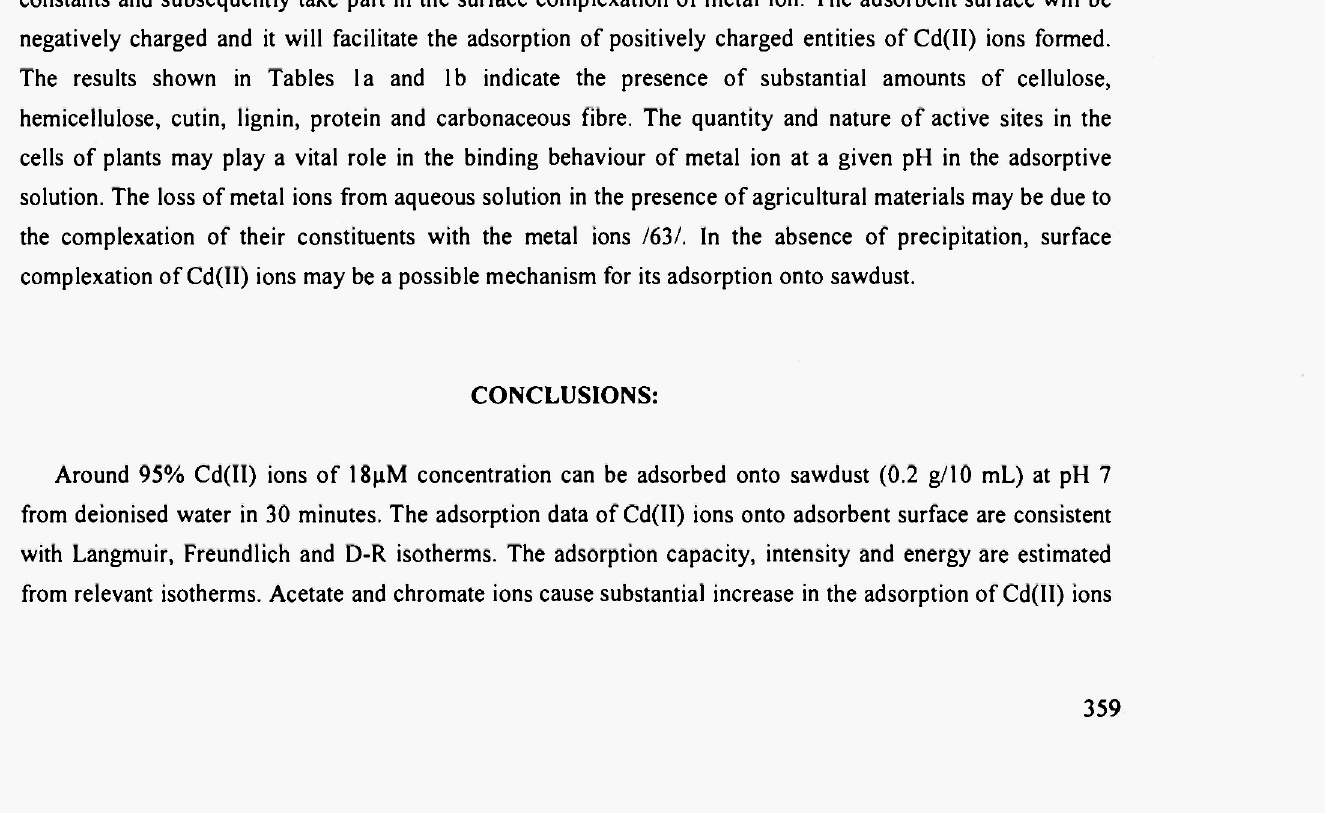
The plant cells have different chemical compositions depending on their species. The binding sites in the cells are carbohydrates, amines, hydroxyl and other functional groups in the cell proteins and sugars 1621. The adsorption of Cd(ll) ions onto sawdust is given in Table 2 as a function of pH. The adsorption mechanism may be due to different functional groups present on the adsorbent surface such as -NH 3+ , - OH and fibre carbonaceous C x OH. These functional groups may dissociate at different pHs as per their acidic dissociation constants and subsequently take part in the surface complexation of metal ion. The adsorbent surface will be negatively charged and it will facilitate the adsorption of positively charged entities of Cd(II) ions